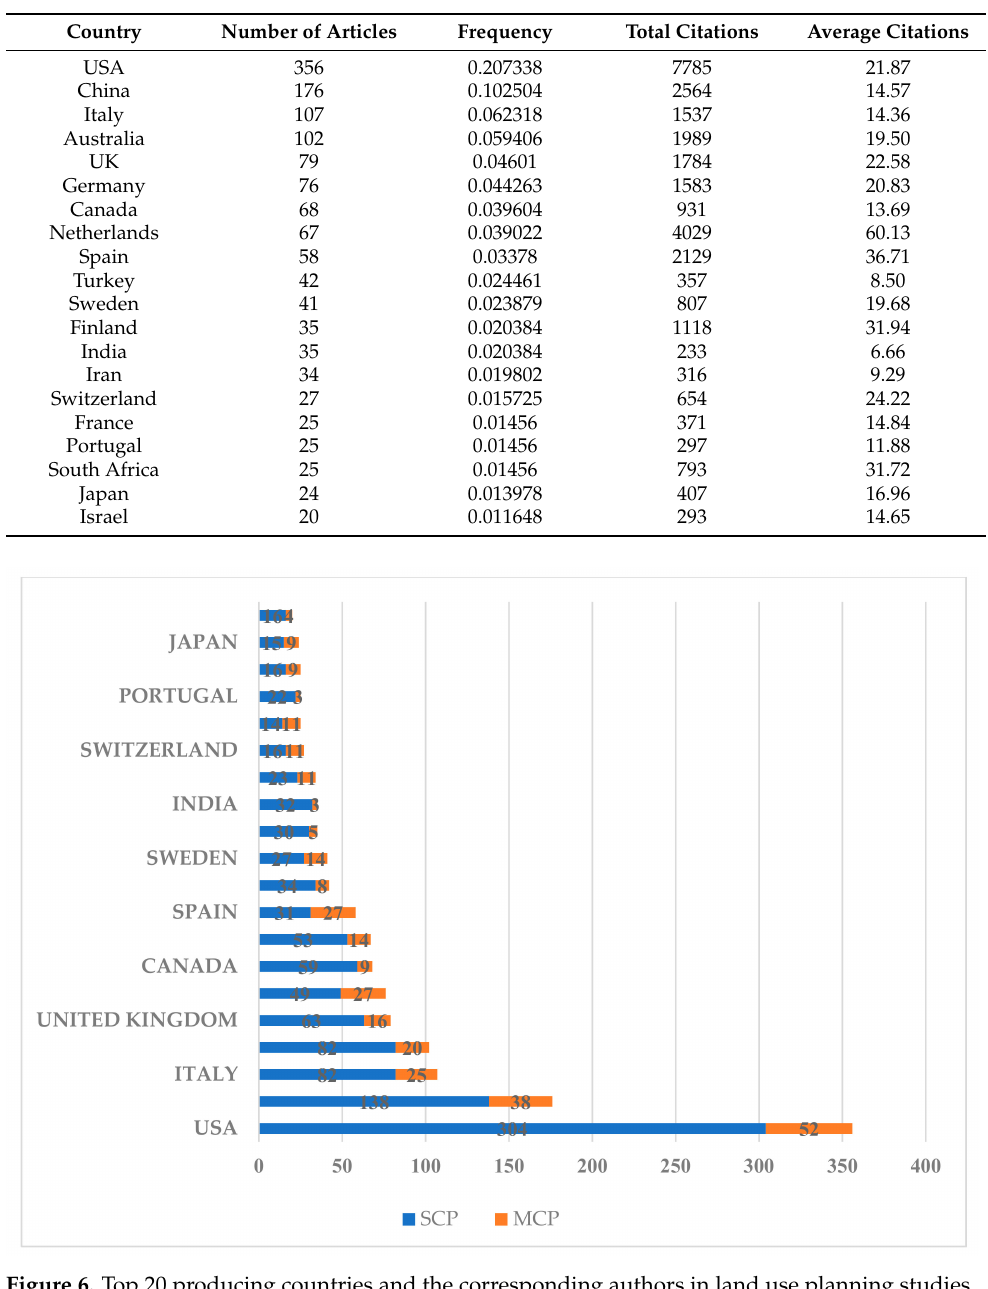
Table 3. Status of the main countries engaged in land use planning from 1990 to 2019.